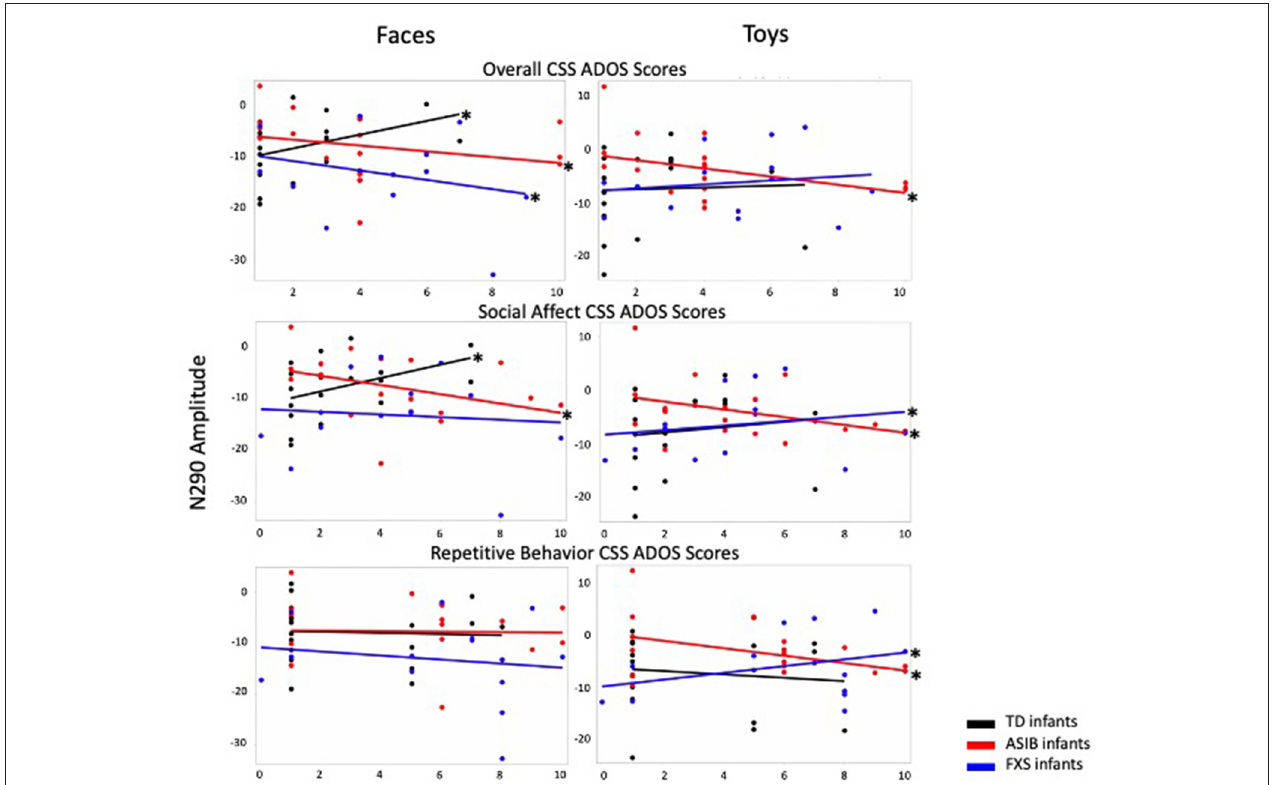
FIGURE 1 | N290 amplitude to faces and toys across ASIBs, infants with FXS, and LRC infants is presented in relation to Overall, Social Affect, and Restricted and Repetitive Behavior calibrated severity scores. Average N290 amplitude is calculated across Parietal Occipital, Lateral Parietal, and Temporal Parietal electrodes.